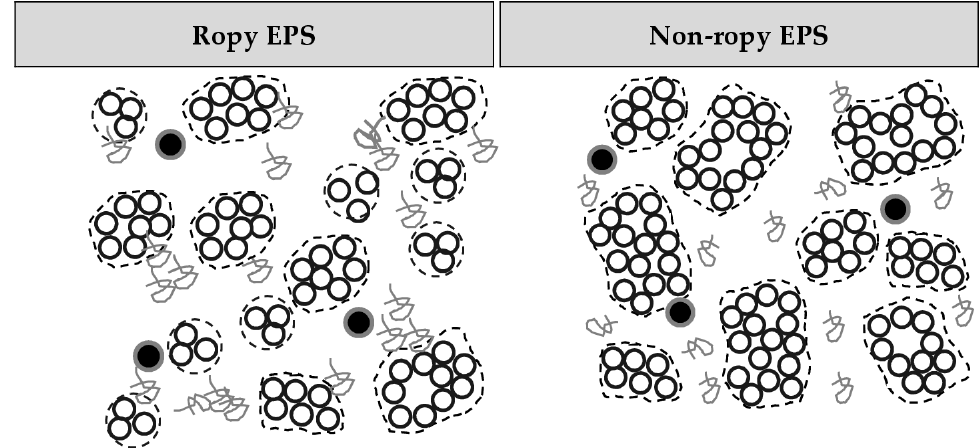
Figure 8. Schematic representation of the microstructure of stirred gels: casein associated with denatured whey protein (black, open), ropy or non-ropy EPS (grey) and cells (black, closed) with capsular EPS (dark gray border) in the serum (white).